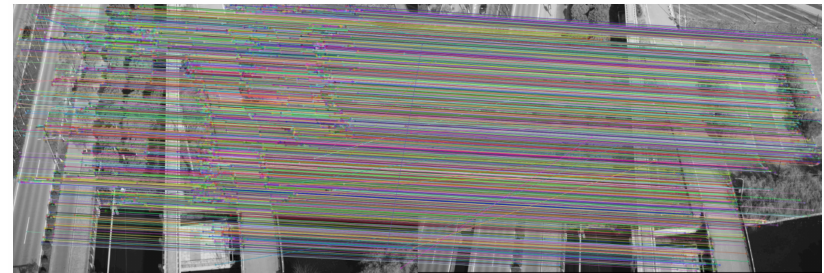
Figure 3. RANSAC algorithm to eliminate seed image feature matching